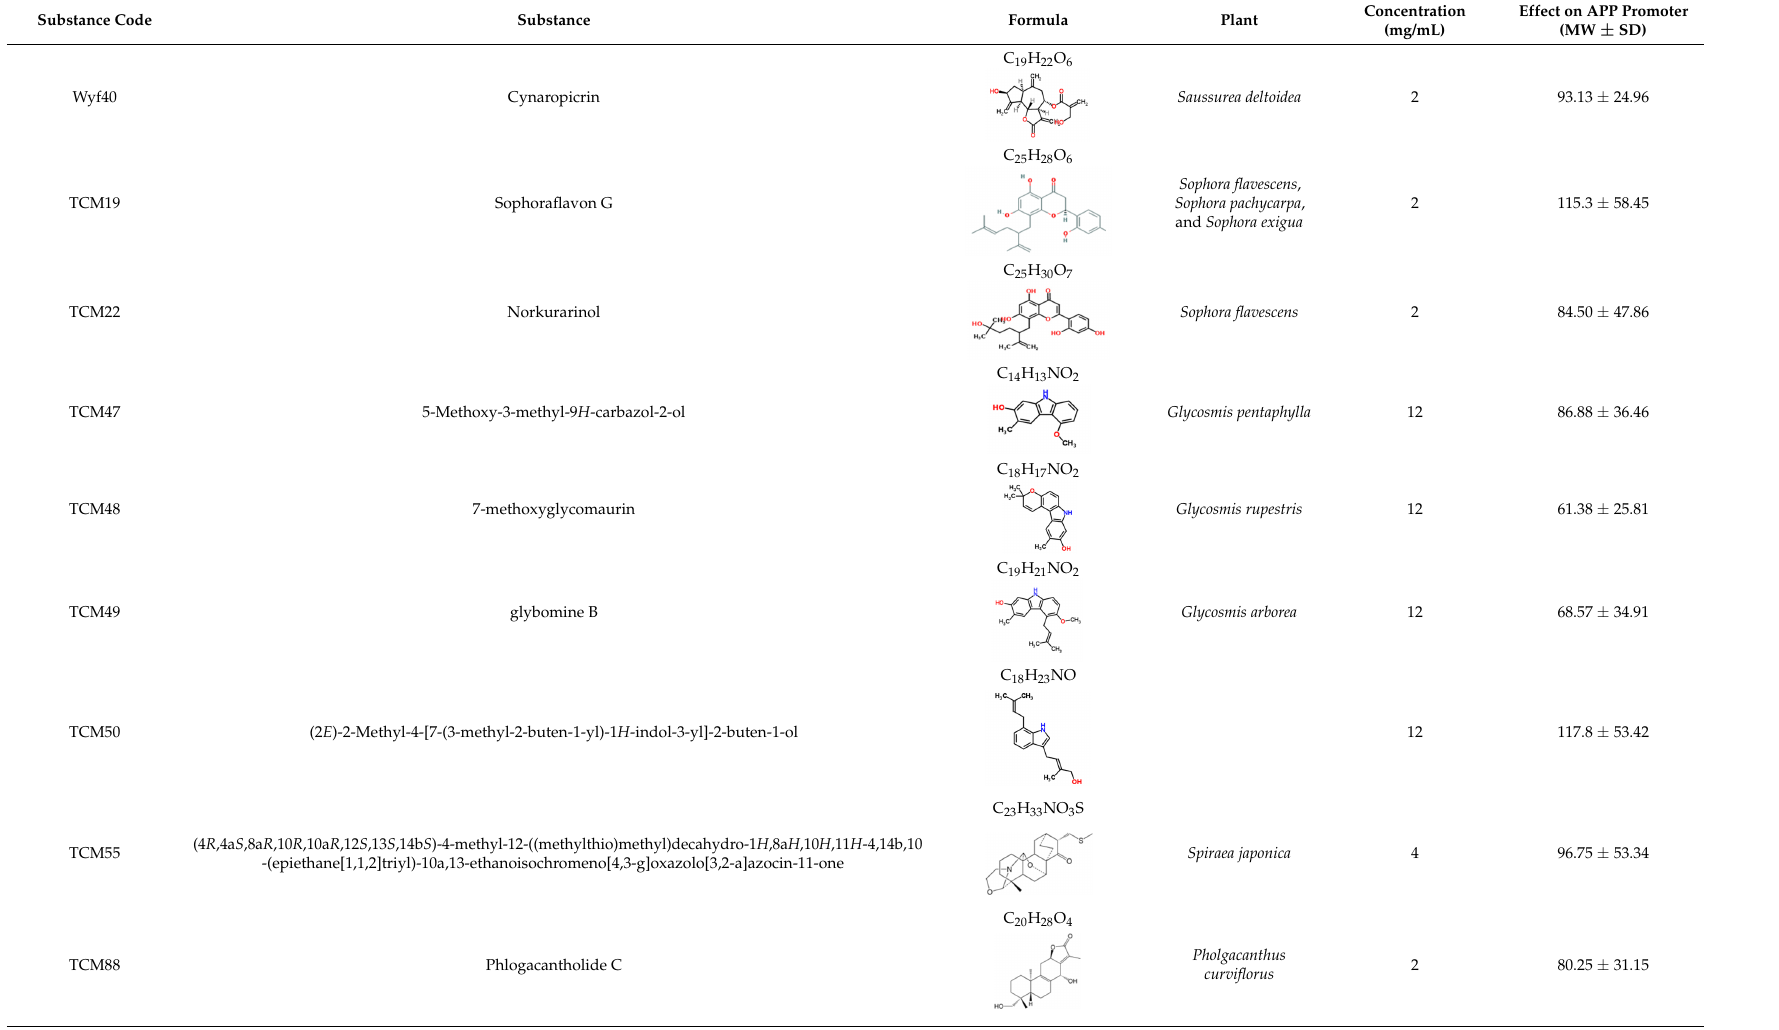
Table 1. Candidate substances selected from dual promoter assay.